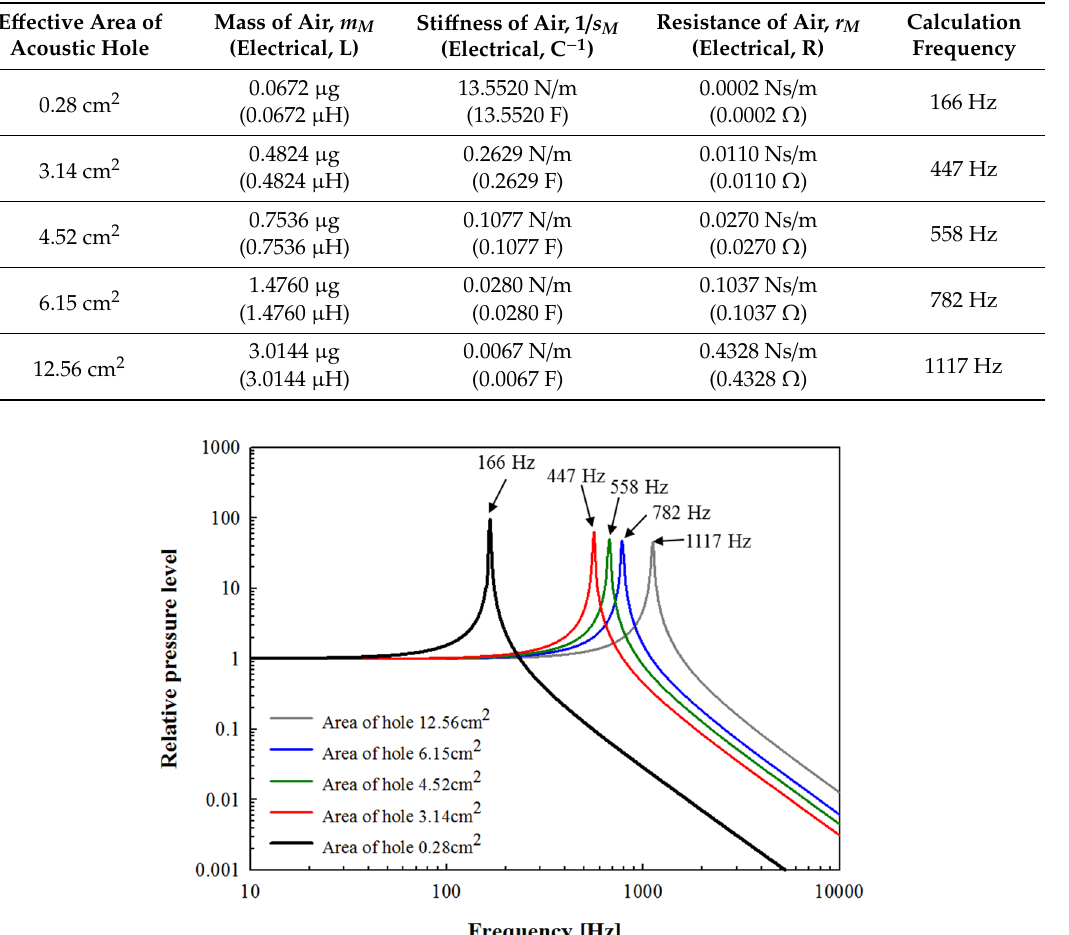
Table 2. Simulation parameters and calculation frequency according to the acoustic hole size.